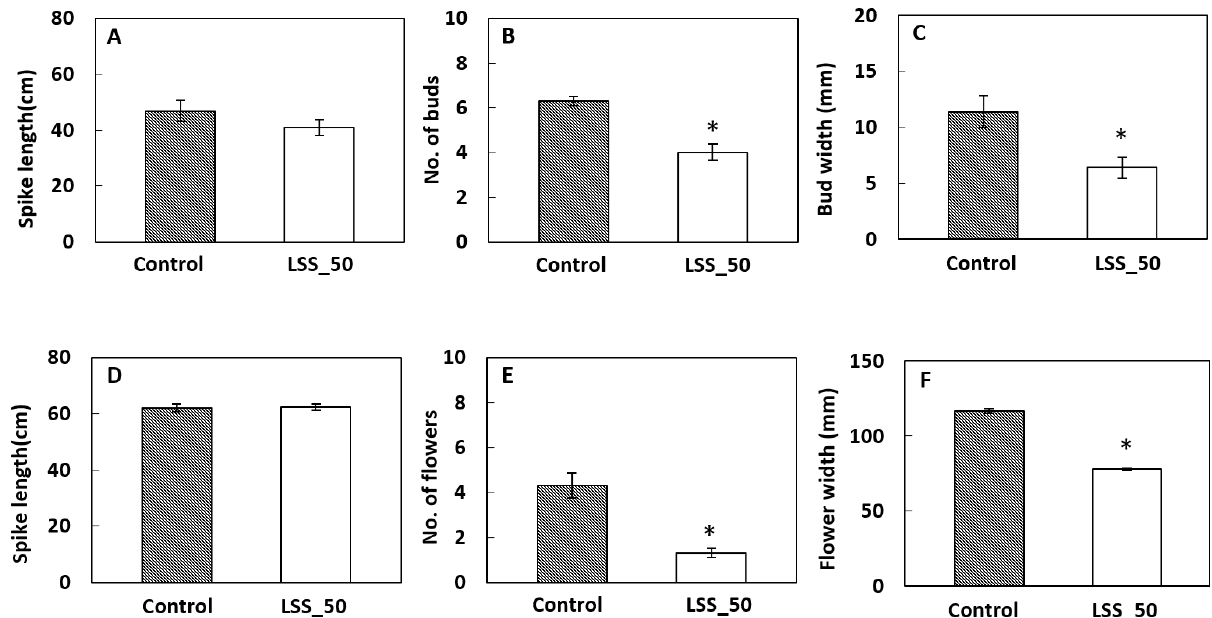
Figure 10. Characteristics of subsequent flowering quality of Phalaenopsis Sogo Yukidian ‘V3’ of the control and simulated light shipping for 50 days (LSS_50) at 100 ( A – C ) and 130 ( D – F ) days after simulated shipping. * p ≤ 0.05.